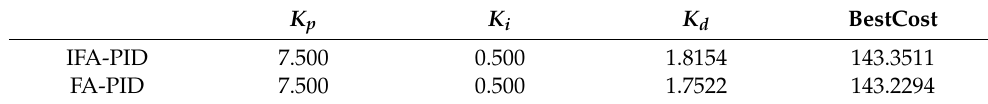
Table 3. Optimization parameters under PID controller and error integration index. Table 4. Optimization parameters under LADRC and error integration index.